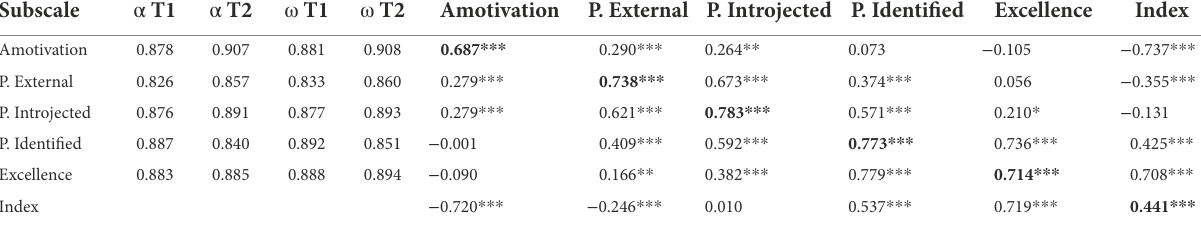
TABLE 11 MPSES correlations and reliabilities, Study